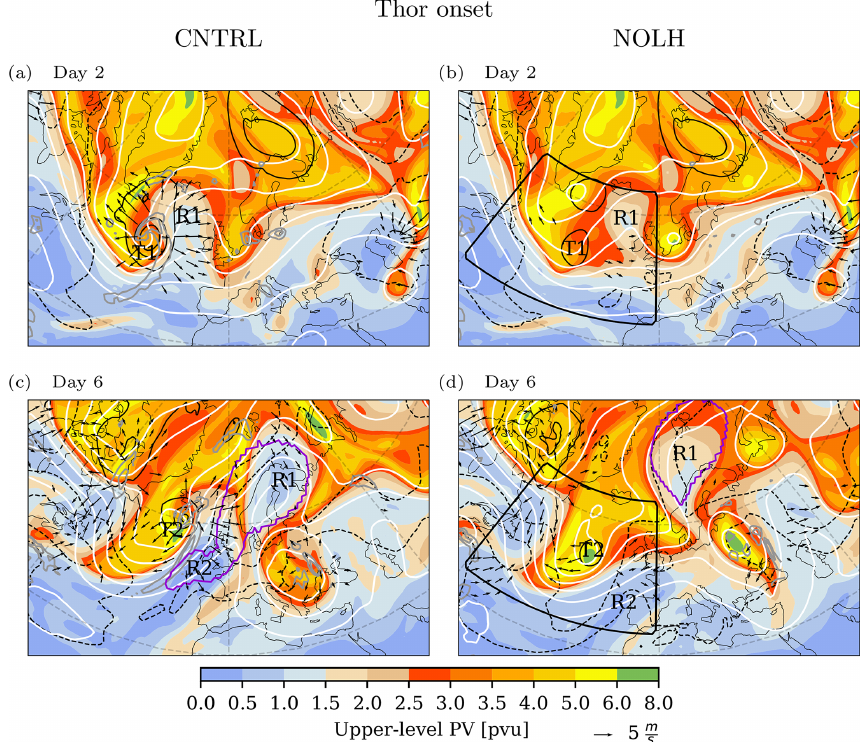
Figure 3. Upper-level PV (in potential vorticity units, shaded), upper-level divergent wind (black vectors according to reference vector, only shown for wind speed larger than 2ms − 1 ), geopotential height at 500hPa (white contours every 100gpm), cloud-diabatic (cloud microphysics and convection) heating (1 and 3K(3h) − 1 in gray contours, vertically integrated between 900 and 500hPa), SLP (solid black contours from 1000hPa every − 10hPa, dashed contours from 1020hPa every + 10hPa), and blocking region (violet contour for PV anomaly of − 1pvu) in the (a, c) CNTRL and (b, d) NOLH simulations at (a, b) 00:00UTC 2 October 2016 (day 2) and (c, d) 15:00UTC 5 October 2016 (day 6). Labels “T1–T5” mark troughs (cyclones) and “R1–R5” mark ridges (anticyclones) as described in the text. The black box in NOLH indicates the region where LH is turned